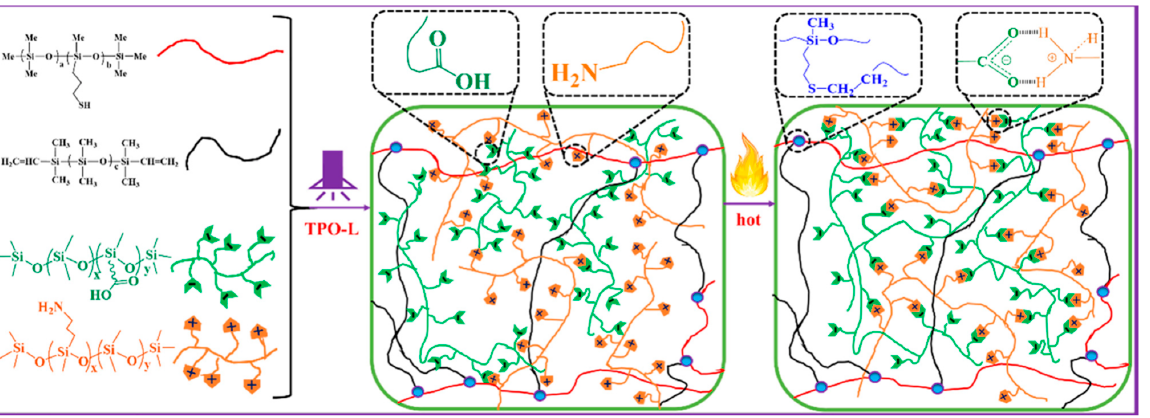
Figure 36. Self-healing polysiloxane elastomers. Reprinted/adapted with permission from Ref. [138]. Copyright (2020), with permission from Elsevier.